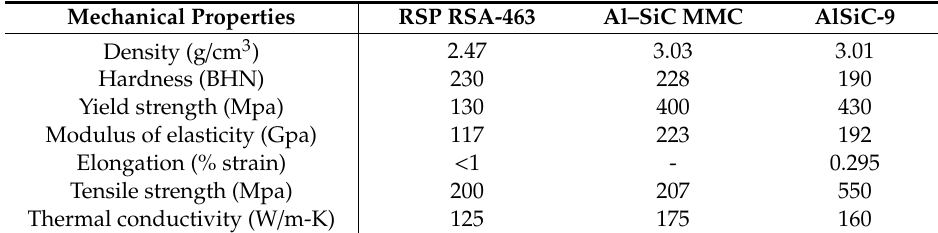
Table 2. Mechanical properties of other comparable hypereutectic (Al–Si) alloys.